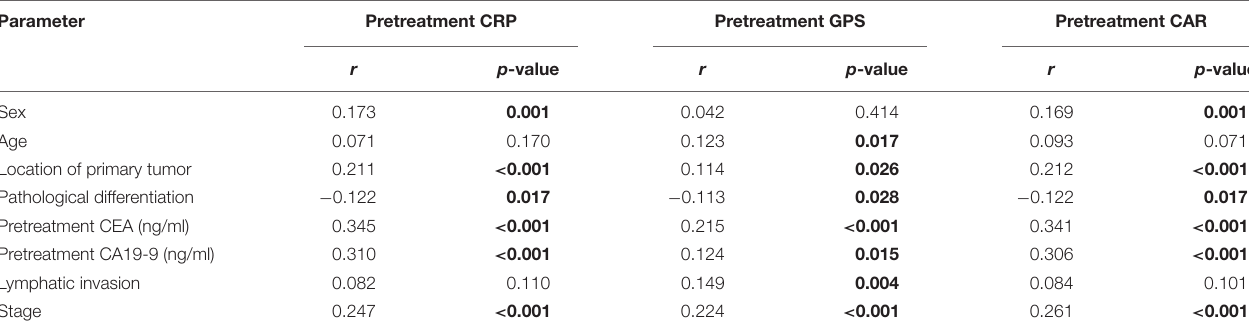
FIGURE 2 | Optimal cutoff levels for the C-reactive protein/albumin ratio (CAR) were applied with the receiver operating characteristic (ROC) curves for overall survival in all recruited colorectal cancer (CRC) patients (A) , in stage I–III CRC patients (B) , and in colorectal liver metastases (CRLM) patients (C) . TABLE 1 | Significant correlations of pretreatment CRP, GPS, and CAR with the clinicopathological features in CRC